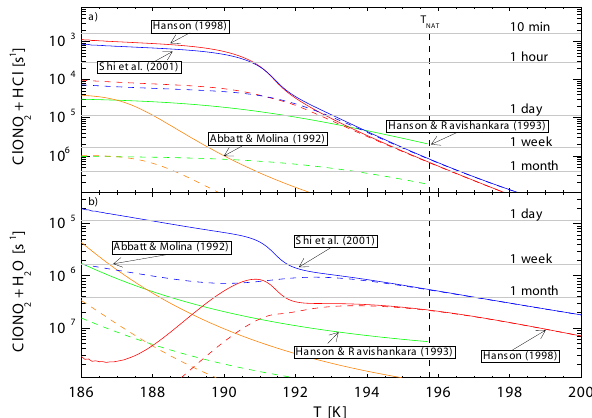
Fig. 1. First order loss rates for ClONO 2 +HCl (a) and ClONO 2 +H 2 O (b) for different parameterizations and aerosol types for typical stratospheric conditions (50hPa, 5ppmv H 2 O, 1ppbv HCl, 0.5ppbv ClONO 2 , 10ppbv HNO 3 , 0.15ppbv H 2 SO 4 and 10 background aerosol particles cm − 3 ). Solid red and blue lines de- pict ternary aerosol, dashed lines binary aerosol. Solid green and or- ange lines represent NAT particles with density 10 − 1 cm − 3 , dashed lines 10 − 4 cm − 3 . Adapted from Dameris et al.